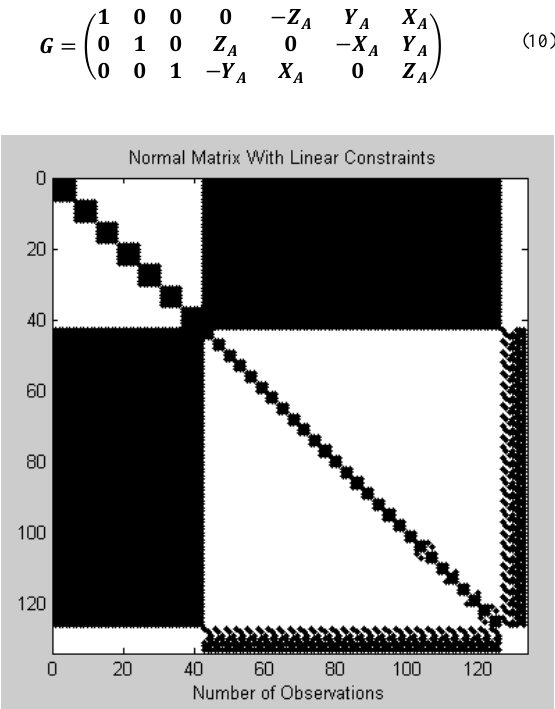
Figure 7. Final Form of Normal